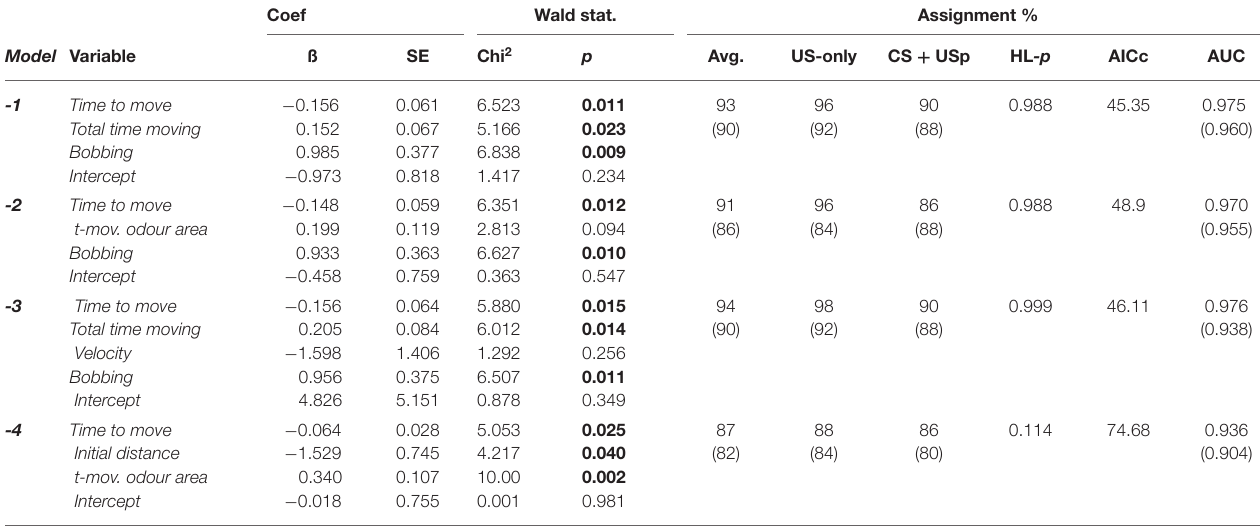
TABLE 2 | Comparison of binary logistic regression models evaluated for calculating the probability of an animal showing a conditioned odour response ( P resp ). Coef Wald stat. Assignment